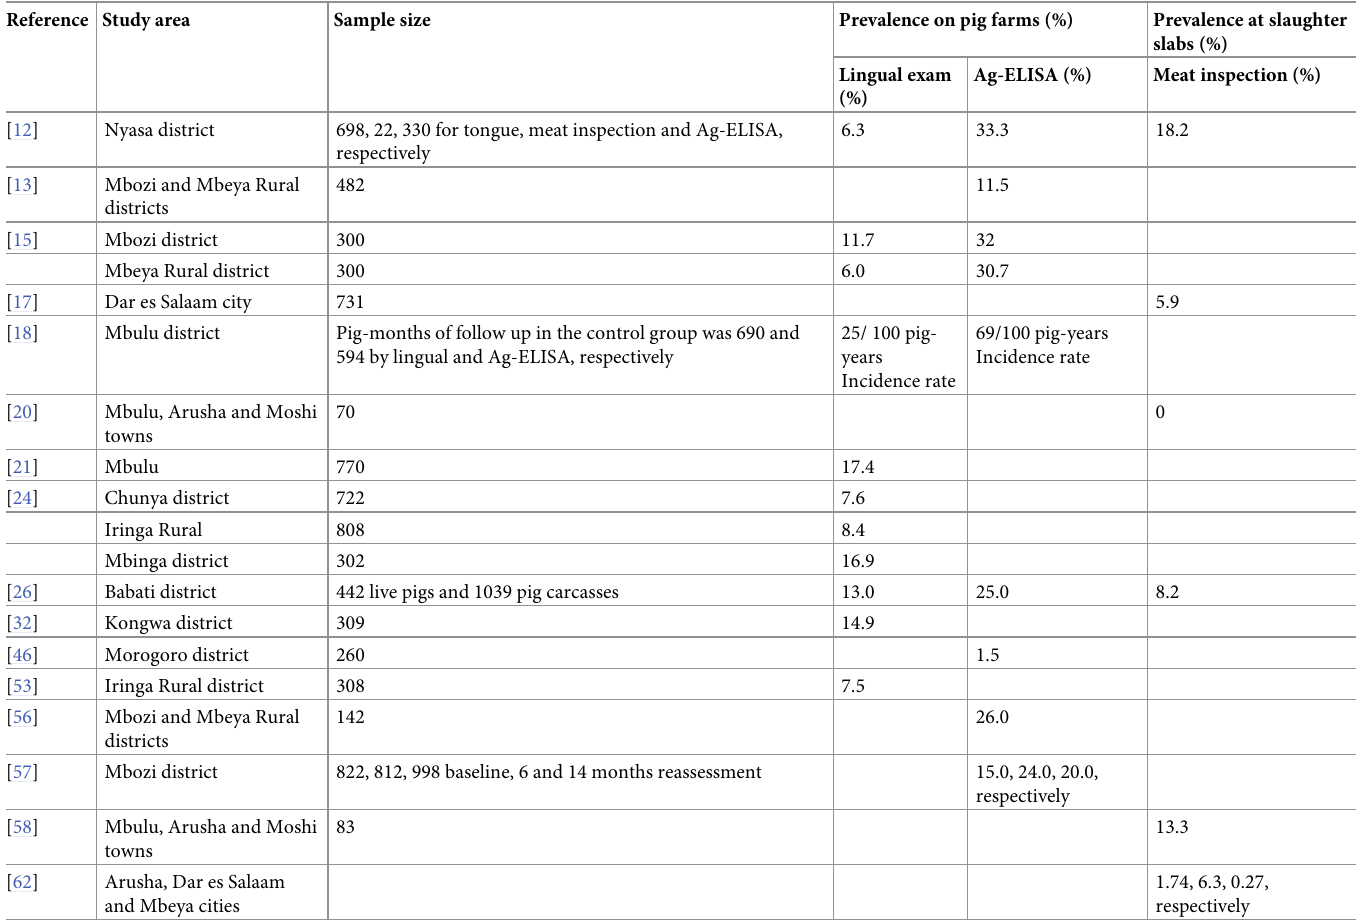
Table 3. Prevalence of porcine cysticercosis on pig farms and at slaughter slabs in Tanzania,